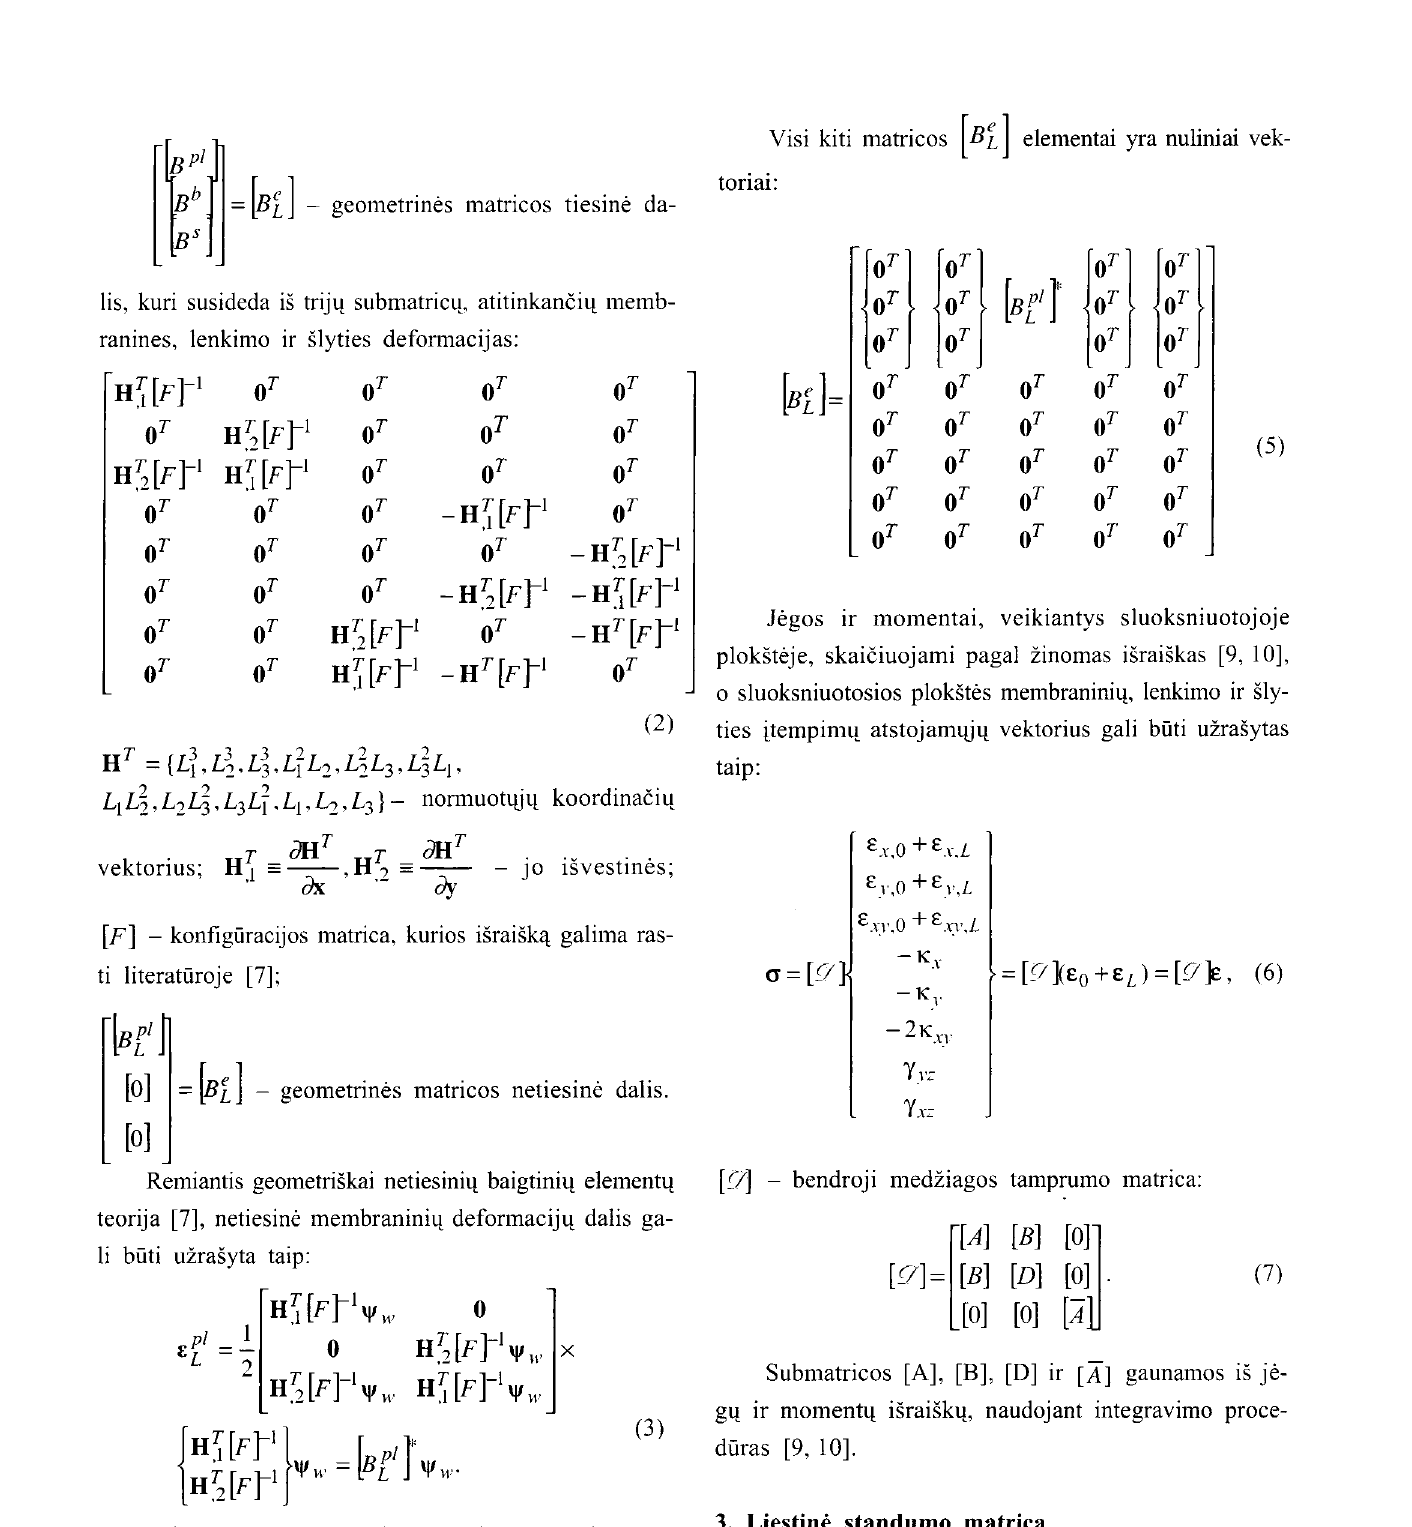
Taip gaunama geometrines matricos netiesines